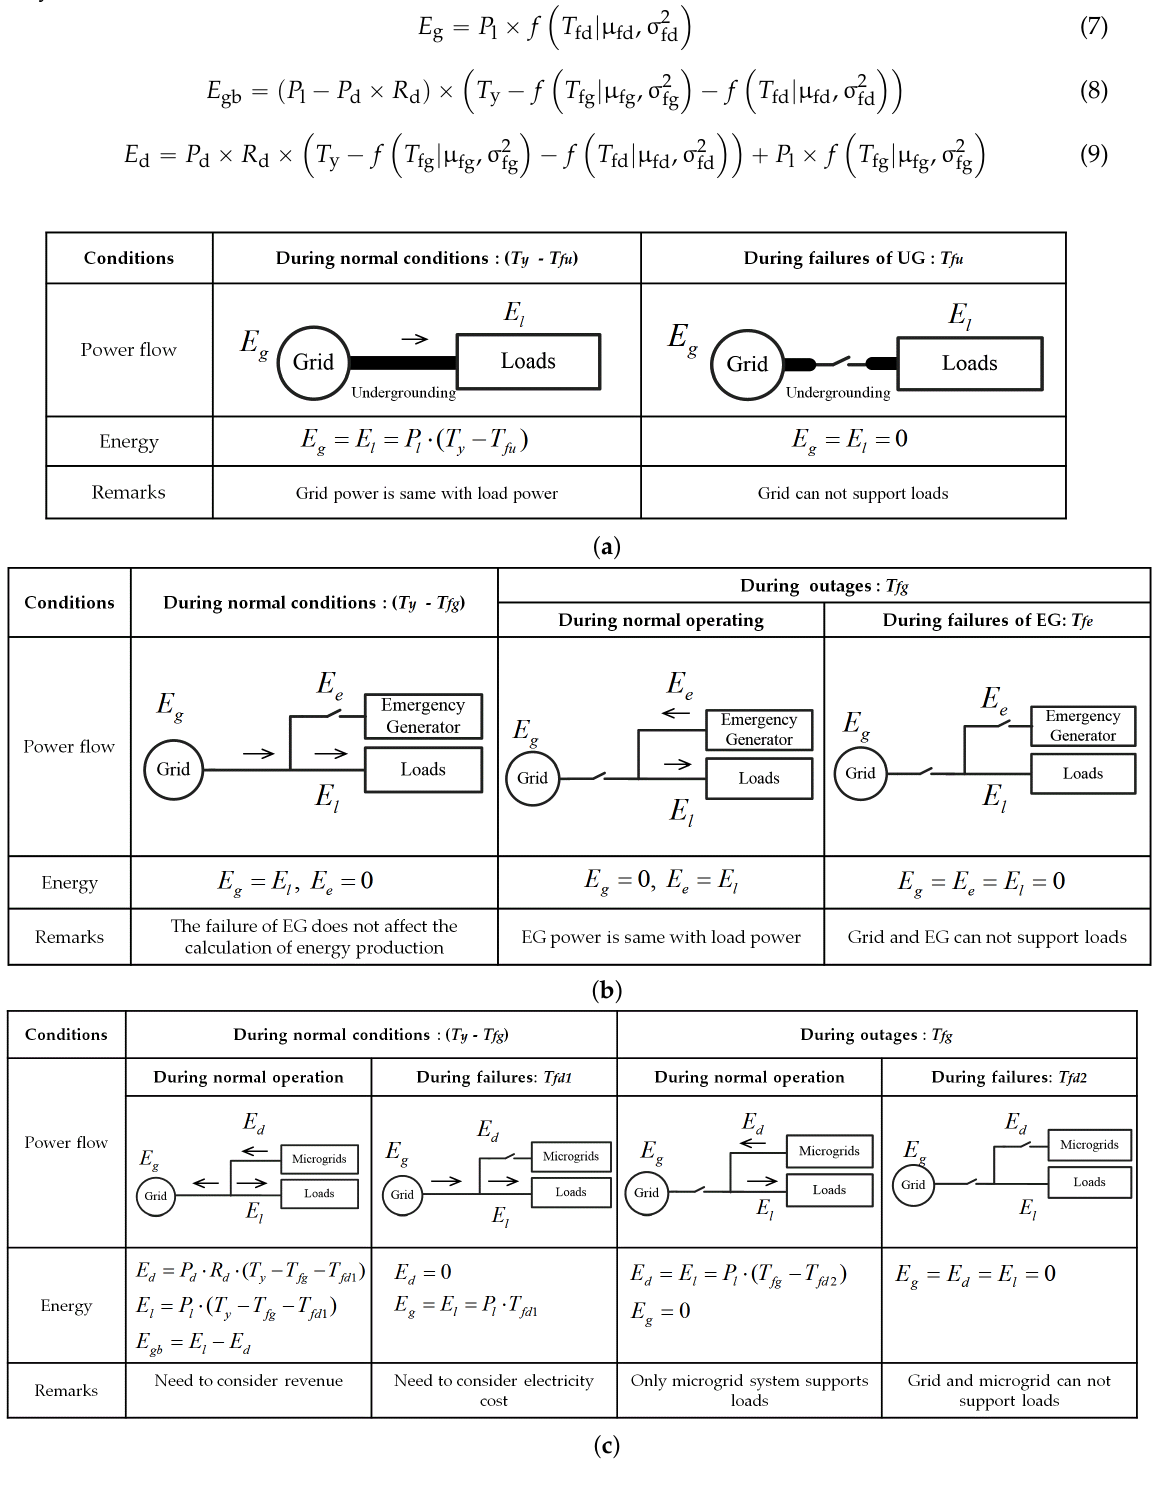
Figure 3. Power flow diagram for calcuating energy production: ( a ) undergrounding (UG); ( b ) emergency generator (EG); and ( c ) microgrid